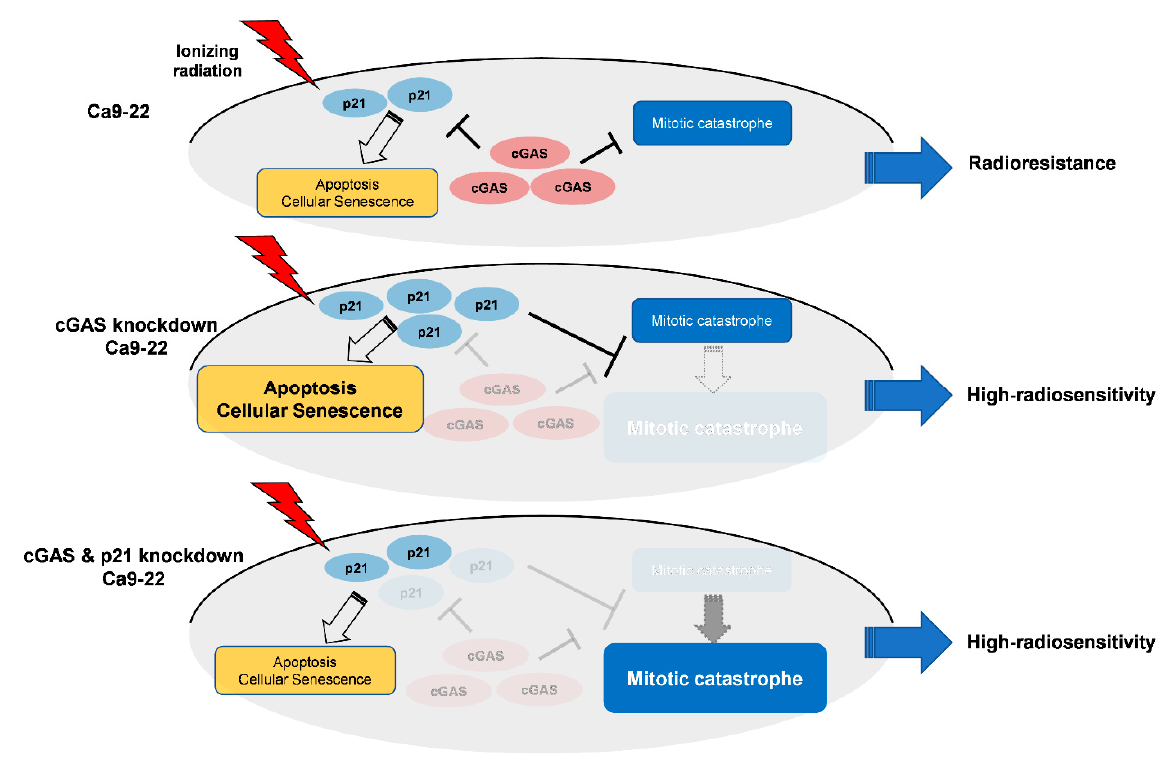
Figure 6. Hypothetical model of the roles of cGAS and p21 in irradiated Ca9-22 cells. Yang et al. showed that the loss of the cGAS gene inhibited radiation-induced senes- cence in mouse embryonic fibroblasts cells, mouse melanoma B16F10, and BJ cells [16]. In contrast, no significant suppression of radiation-induced senescent cells was observed in cGAS knockdown Ca9-22 cells in this study. Although the reason for the discrepancy between their and our report remains unclear, one explanation may be differences in the type of cell lines used in the studies. For example, the tumor suppressor gene TP53 is involved in the induction of cellular senescence [47]. All cell lines used in Yang’s report had wild type TP53, whereas TP53 was mutated in both the SAS and Ca9-22 cell lines (refer to the review report of [18]).